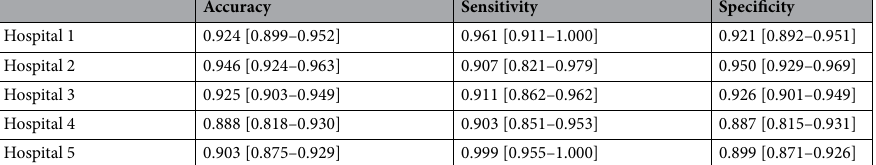
Table 2. Accuracy, sensitivity, and specificity for the five test sets using the model at × 20 with tile size 512 × 512px. All these values were computed at a probability threshold of 0.5. The ROC curves in Fig. 2 provide more representative values for sensitivity and specificity across the range of threshold from 0.0 to